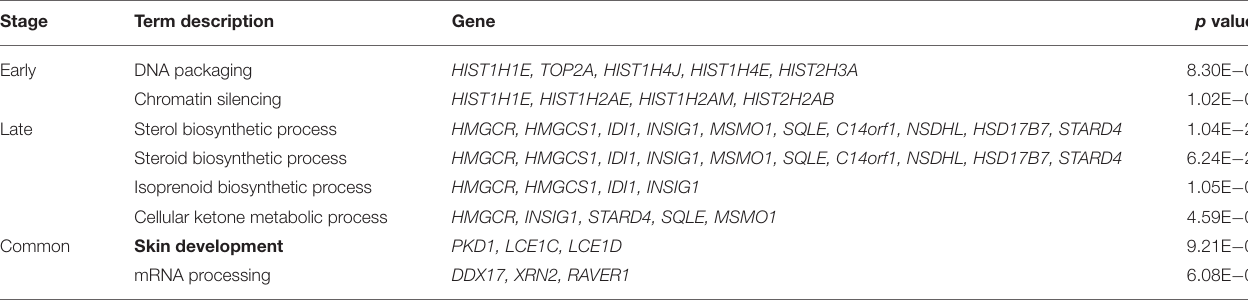
TABLE 2 | GO * terms of hub genes.